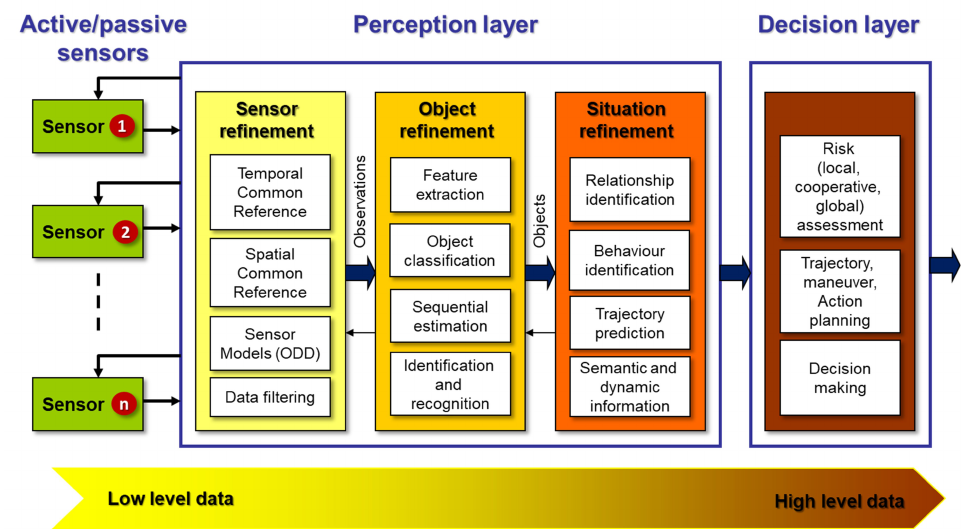
Figure 1. Perception and decision